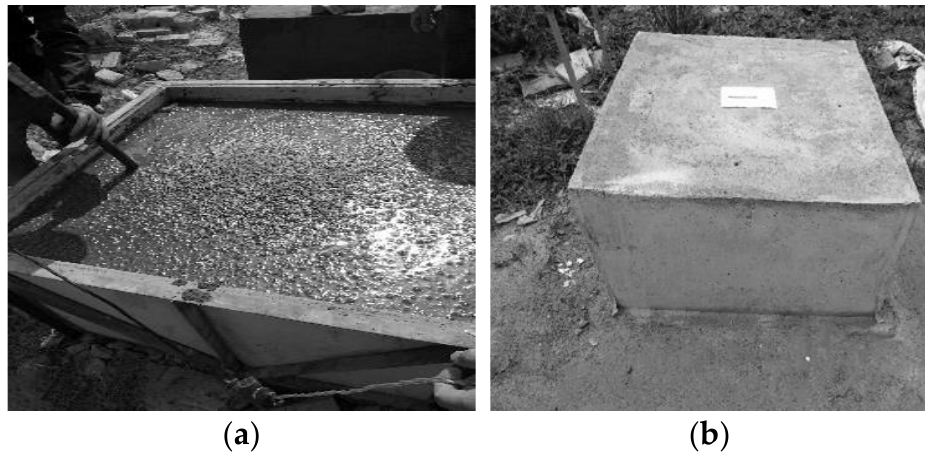
Figure 4. Test model: ( a ) model concreting process, ( b ) individual models.